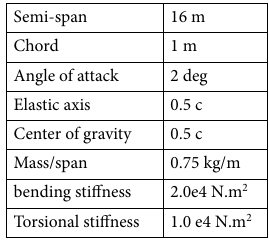
Table 1. Simulation parameters.